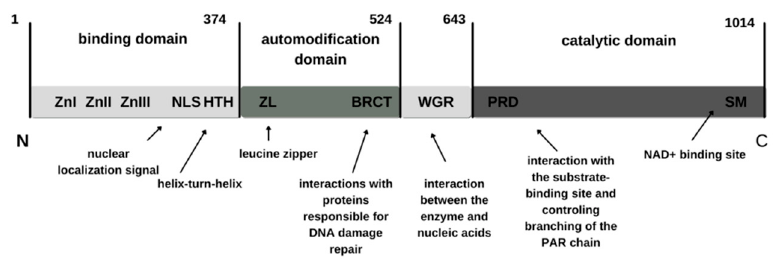
Figure 1. Structure of PARP-1. Sequence ends: the N-terminus and the C-terminus.